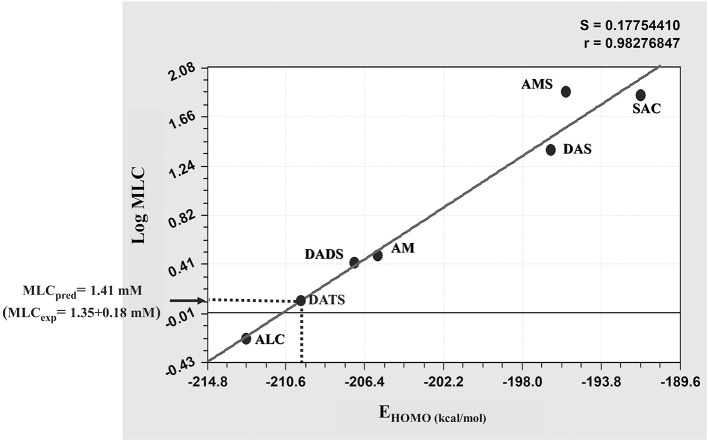
Linear regression model for the MLC-EHOMO relationship of thioallyl compounds (TACs). The values of giardicidal activity (MLC) and the electronic descriptor EHOMO of the six TACs included as “drivers” were processed by multiple linear regression and the value of EHOMO calculated for the “test” compound diallyl trisulfide (DATS) was interpolated in the model (dotted line) to predict the MLC of this compound and to compare it with its experimetal MLC. Abbreviations of compound names are as indicated in section Materials and Methods.